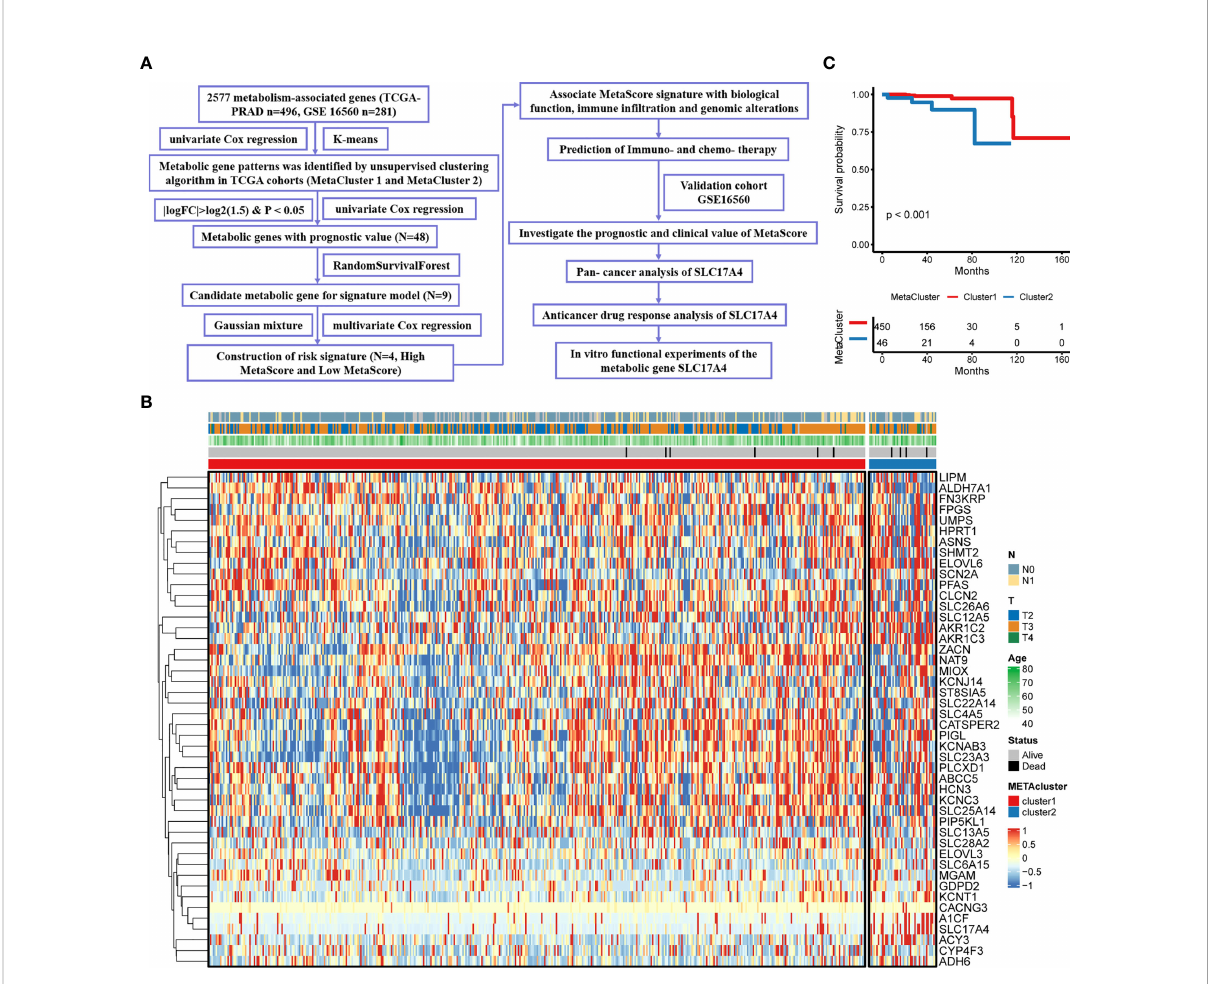
FIGURE 1 Characteristics of MetaCluster in PCa. (A) Flow chart of the study. (B) Heatmap of the candidate genes associated with MetaCluster. (C) Kaplan – Meier curves showing the correlation between MetaCluster and OS (log-rank test, P<